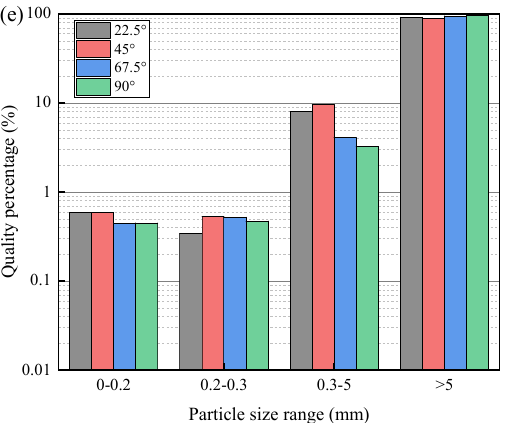
Figure 11. Percentage mass distribution of debris particle size at different lamination angles. ( a ) v = 1.737 m/s, ( b ) v = 2.351 m/s, ( c ) v = 2.728 m/s, ( d ) v = 3.309 m/s, and ( e ) v = 4.008 m/s. For coal rock fragments with a particle size greater than 5 mm, the fragment scale ratio distribution is shown in Figure 12. In Figure 12a, for the specimen with the bedding orientation of 0 ◦ , the length-to-thickness ratio of the debris basically ranged from 1.3 to 6.3, with an average value of 2.64. It was concentrated in the range of 2 to 3.5, mainly in the form of lumpy debris, including some plate debris, with a representative size of L:W:D = 3:2:1 ( L , W and D are the length, width and density of the debris, respectively). In Figure 12b, for the specimen with the bedding orientation of 22.5 ◦ , the length-to-thickness ratio of the debris ranged from 1 to 5.7, with an average value of 2.54. It was mostly in the form of lumpy debris, with a representative size of L:W:D = 2.0:1.8:1.0. The specimen with a bedding orientation of 45 ◦ in Figure 12c had a length-to-thickness ratio of 1.7 to 5, with an average value of 3.08, with the largest number of plate debris and a slightly smaller number of block debris, and a representative size of L:W:D = 3:2:1. The specimen with a bedding orientation of 67.5 ◦ in Figure 12d had a length-to-thickness ratio of 1.7 to 5, with an average value of 3.08. The specimen with a bedding orientation of 67.5 ◦ , the length to thickness ratio of the debris was mainly concentrated in the range of 1~3, with an average value of 1.99. It basically consisted of blocky debris, containing some plate debris, with a representative dimension of L:W:D = 2.0:1.5:1.0. The specimen with a bedding orientation of 90 ◦ in Figure 12e, the length to thickness ratio of the debris ranged from 1.3~5.2, with an average value of 2.66. It mainly consisted of blocky debris, containing some plate debris, with a representative dimension of L:W:D =2.0:1.5:1.0. In addition, it contained plate debris with dimensions of L:W:D = 2.5:1.3:1.0. (b) Length to thickness ratio Width to thickness ratio Aspect Ratio